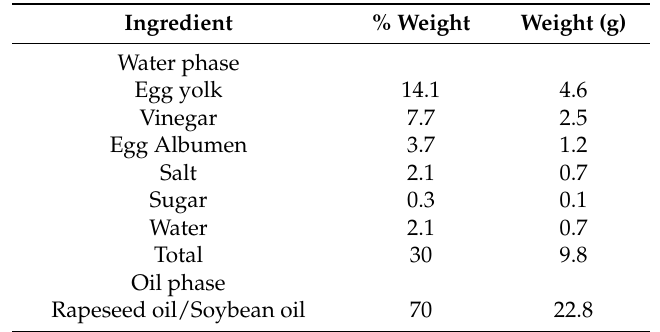
Table 1. Ingredients of the two mayonnaises (prepared in batches of 32.6 g).